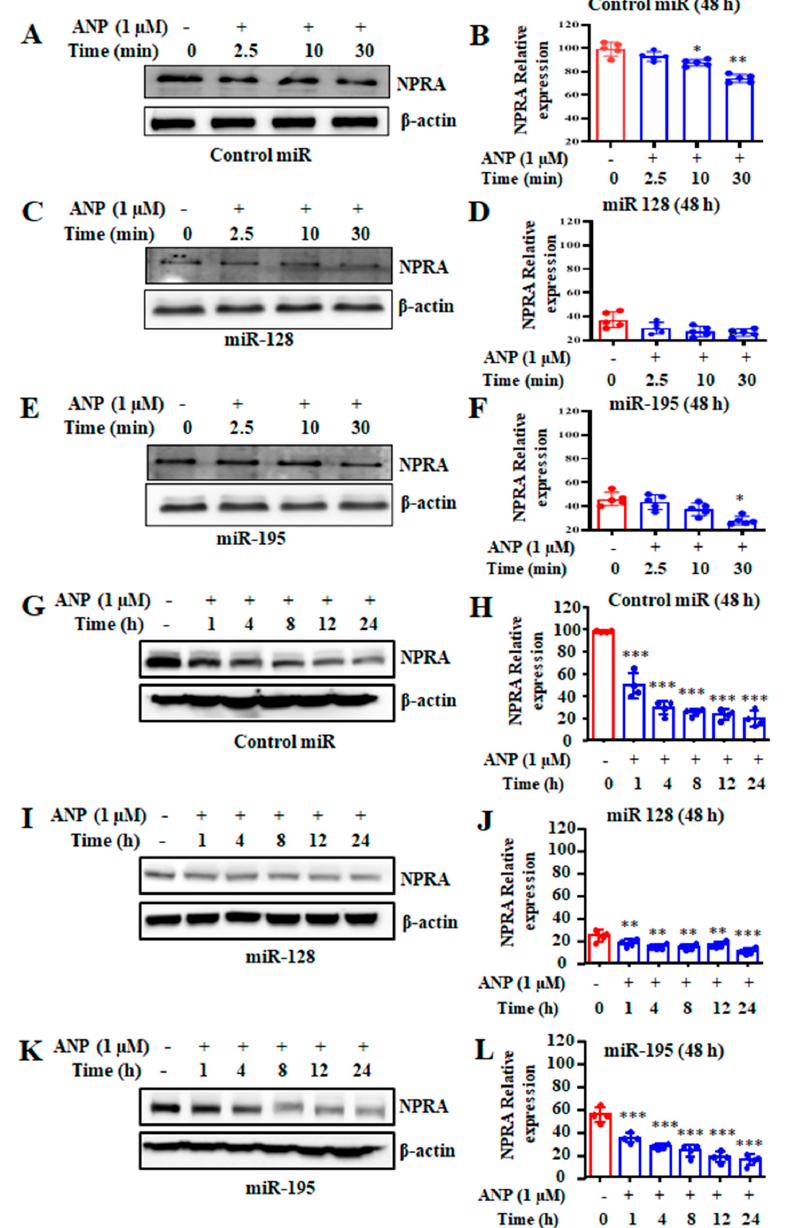
Figure 7. Effect of miRNA overexpression and ANP treatment on NPRA protein levels. HEK-293 cells were transfected with miR-128, miR-195, or vector control (miR control). At 48 h post-transfec- tion, cells were treated with ANP (100 nM) for the indicated times of short-term (0, 2.5, 10, and 30 min) and long-term (0, 1, 4, 8, 12, and 24 h) ANP treatments. After short-term treatments, ( A ) West- ern blot and ( B ) densitometric analysis of NPRA protein was done with the control miR. β -actin level is shown as loading control, ( C ) Western blot and ( D ) densitometric analysis of NPRA protein levels after transfection with miR-128, and ( E ) Western blot and ( F ) densitometric analysis of NPRA protein levels are shown after transfection with miR-195. Similarly, after long-term treatments, ( G ) Western blot and ( H ) densitometric analysis of NPRA protein levels after transfection with the con- trol miR. ( I ) Western blot and ( J ) densitometric analysis of NPRA protein levels after transfection